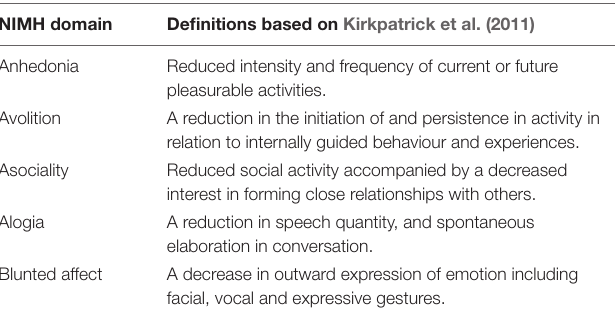
TABLE 1 | Definitions of negative syndrome domains as defined by NIMH consensus. NIMH